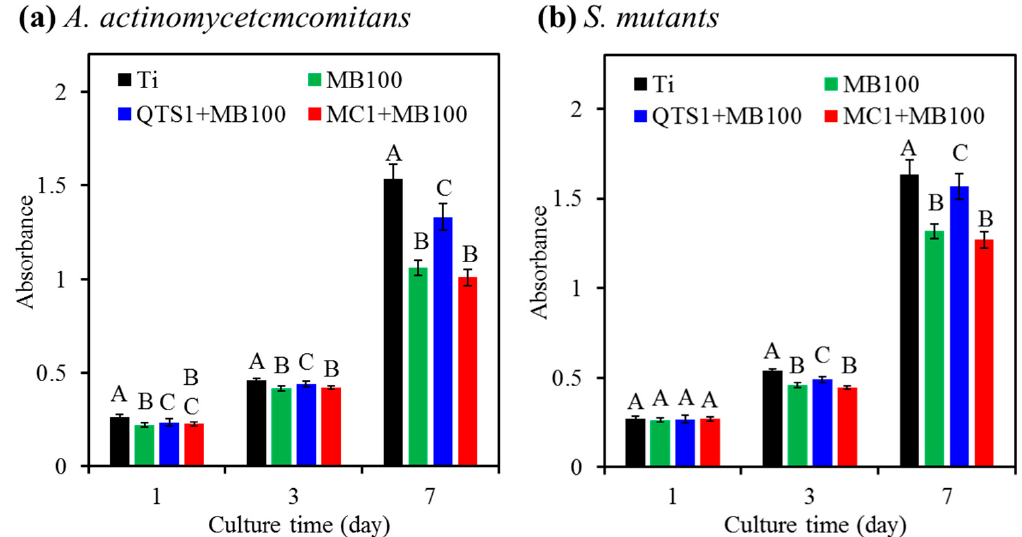
Figure 9. The cell viability was normalized to the negative control (culture medium) in terms of absorbance ( n = 3). Proliferation analysis of MG63 cells cultured on the surfaces after PACT (MB100, QTS1 + MB100 and MC1 + MB100) treated samples contaminated with ( a ) A. actinomycetcmcomitans and ( b ) S. mutants . The sterile Ti alloy was used as a control. Different capital letters showed statistically significant differences at p < 0.05 ( n = 5).